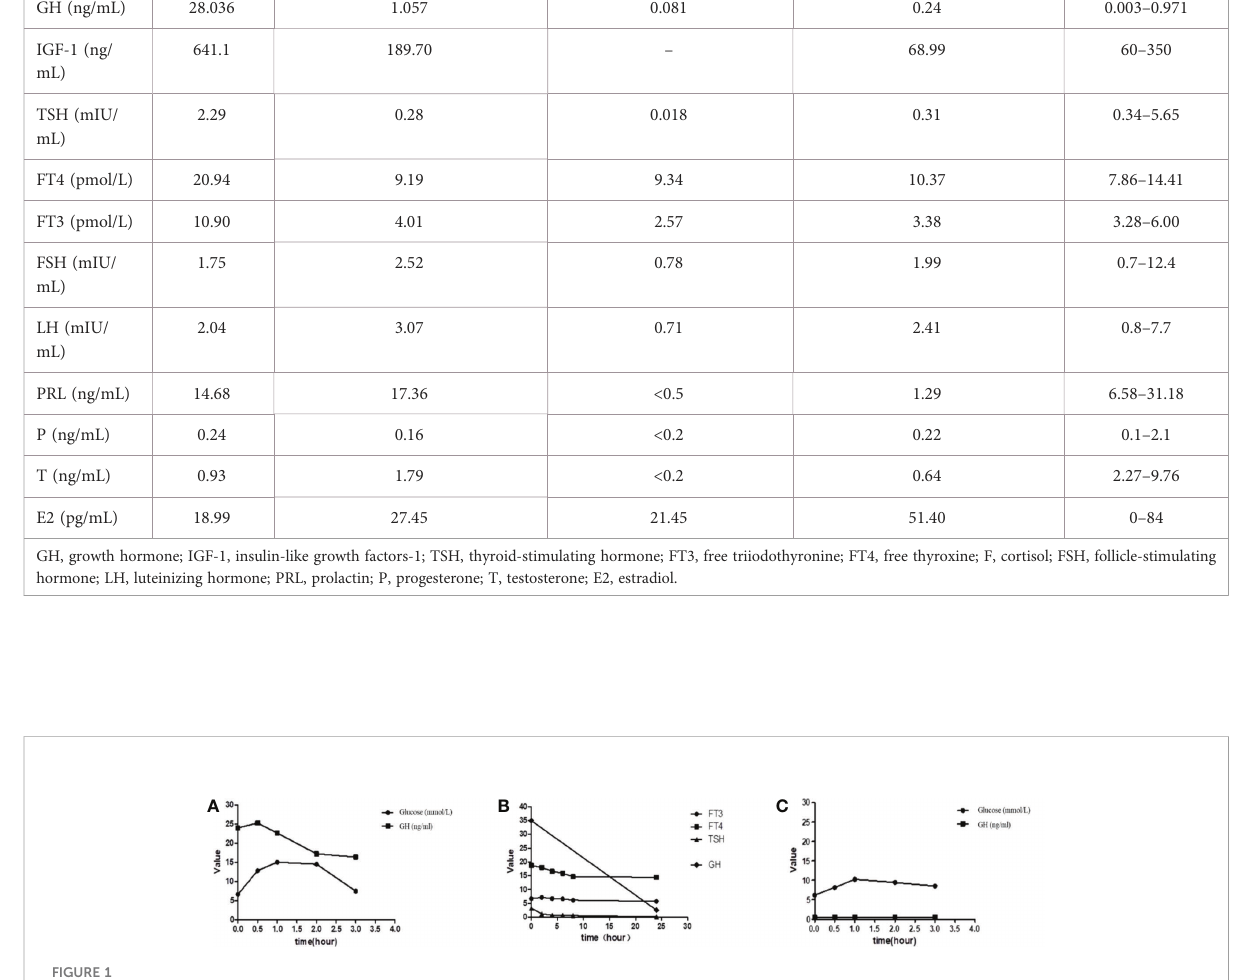
TABLE 1 Changes in relevant hormone indexes before treatment, after octreotide, and after surgery. Before After 6 months of treatment octreotide